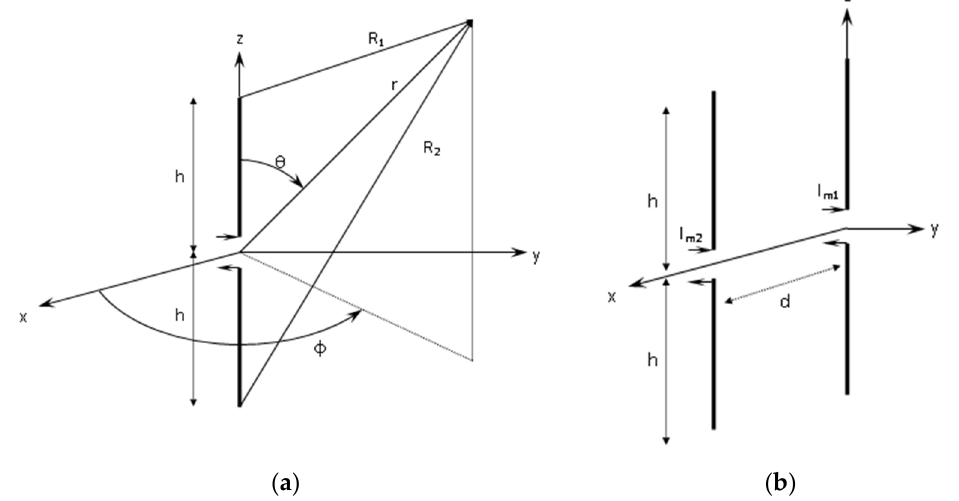
Figure 1. Geometry of the antenna models. ( a ) Equivalent dipole of length 2 h and ( b ) equivalent two-dipole array.